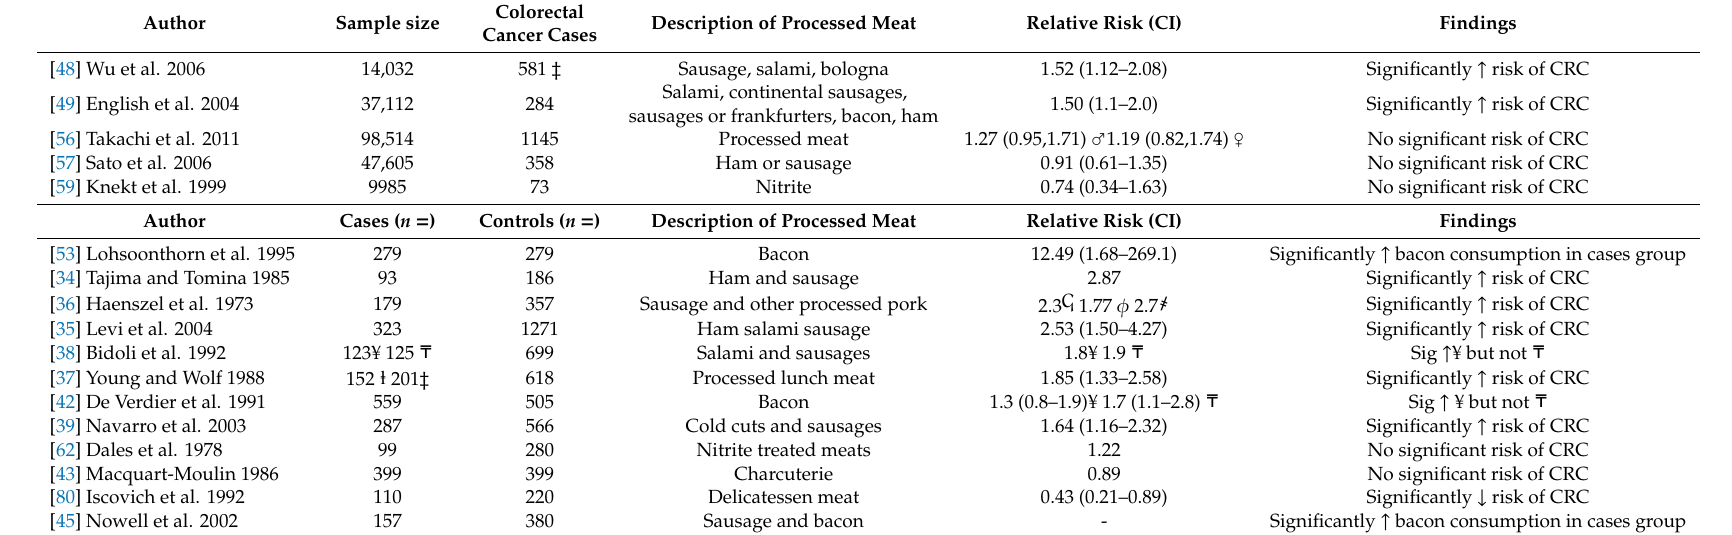
Table 4. Characteristics of prospective and case control human studies assessing colorectal cancer and nitrite containing meat